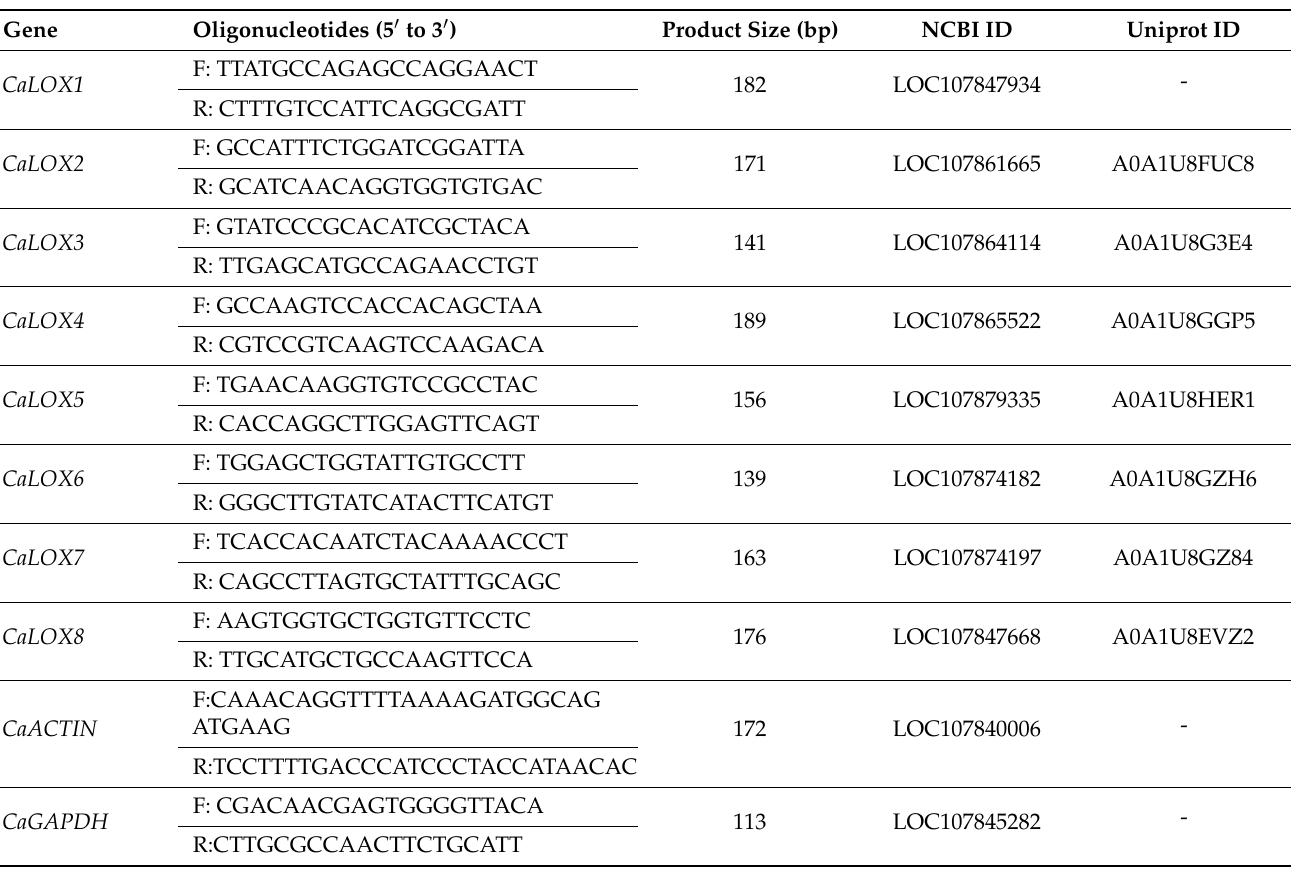
Table 1. Oligonucleotides used for the semiquantitative RT–PCR analysis of CaLOX genes. Letters “F” and “R” correspond to forward and reverse oligonucleotides,